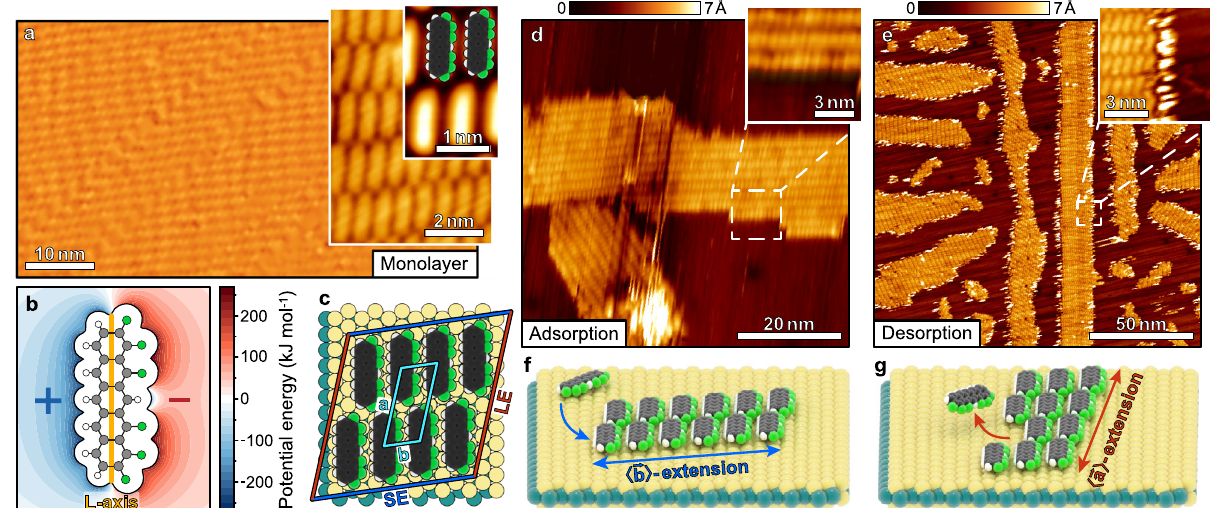
Fig. 1 | Structure of L-F6PEN nanosheets. a STM micrograph of a complete monolayerofL-F 6 PENadsorbedonMoS 2 (U=1.2V,I=40pA).Thelargescanshows asmoothandclosed fi lm,theinsetsshowthemolecularpackingmotif. b Plotofthe outer electrostatic potential of an L-F 6 PEN molecule (C 22 H 8 F 6 ) probed by an elec- tron (cf. ‘ Methods ’ ). Negative values are blue, positive ones red. The white area in thecentrecorrespondstothevdWboxofthemolecule.Carbonatomsareshownin grey, hydrogenatoms in white, and fl uorine atoms ingreen.The orangeline marks the L-axis of the molecule. c Illustration of the unit cell of the L-F 6 PEN (sub-)